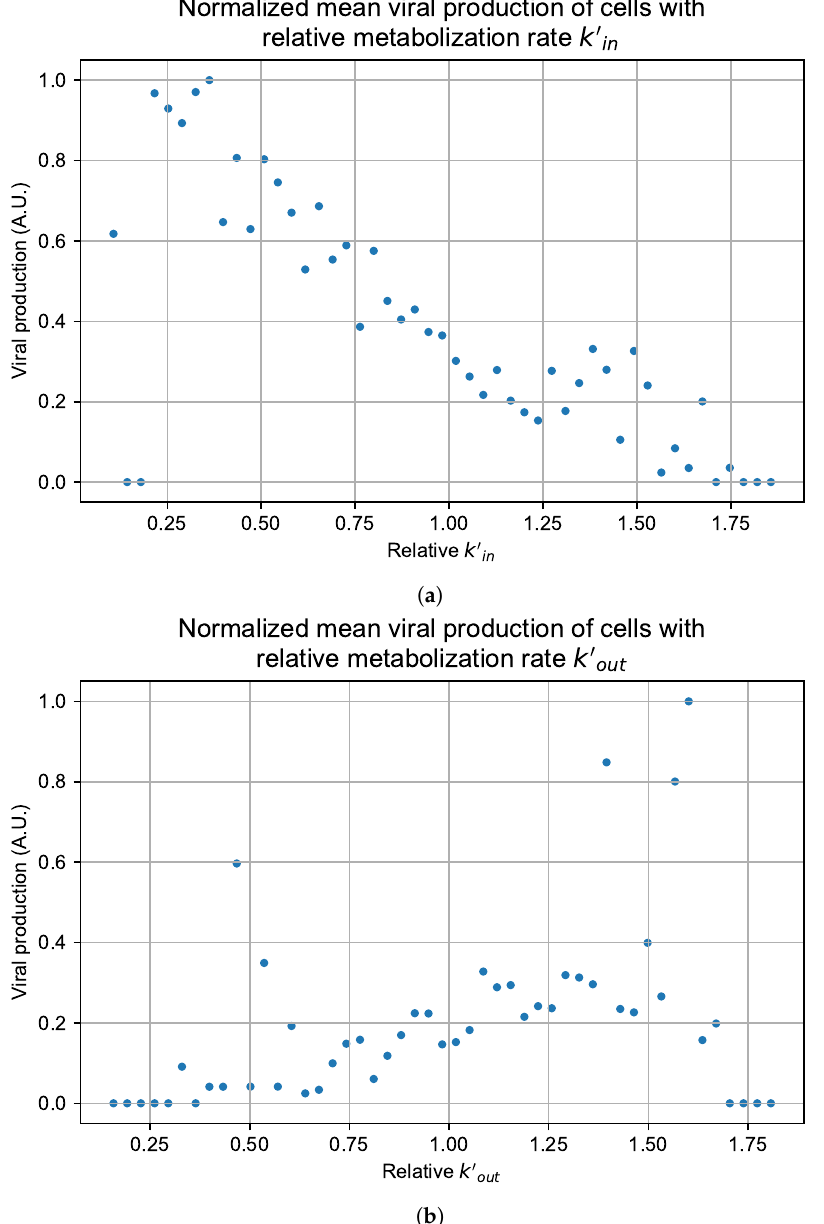
Figure A126. Mean viral production of cells versus their metabolism rates normalized by the maxi- mum mean production with slow clearance parameters. ( a ) Results for simulations varying only k in . ( b ) Results for simulations varying only k out